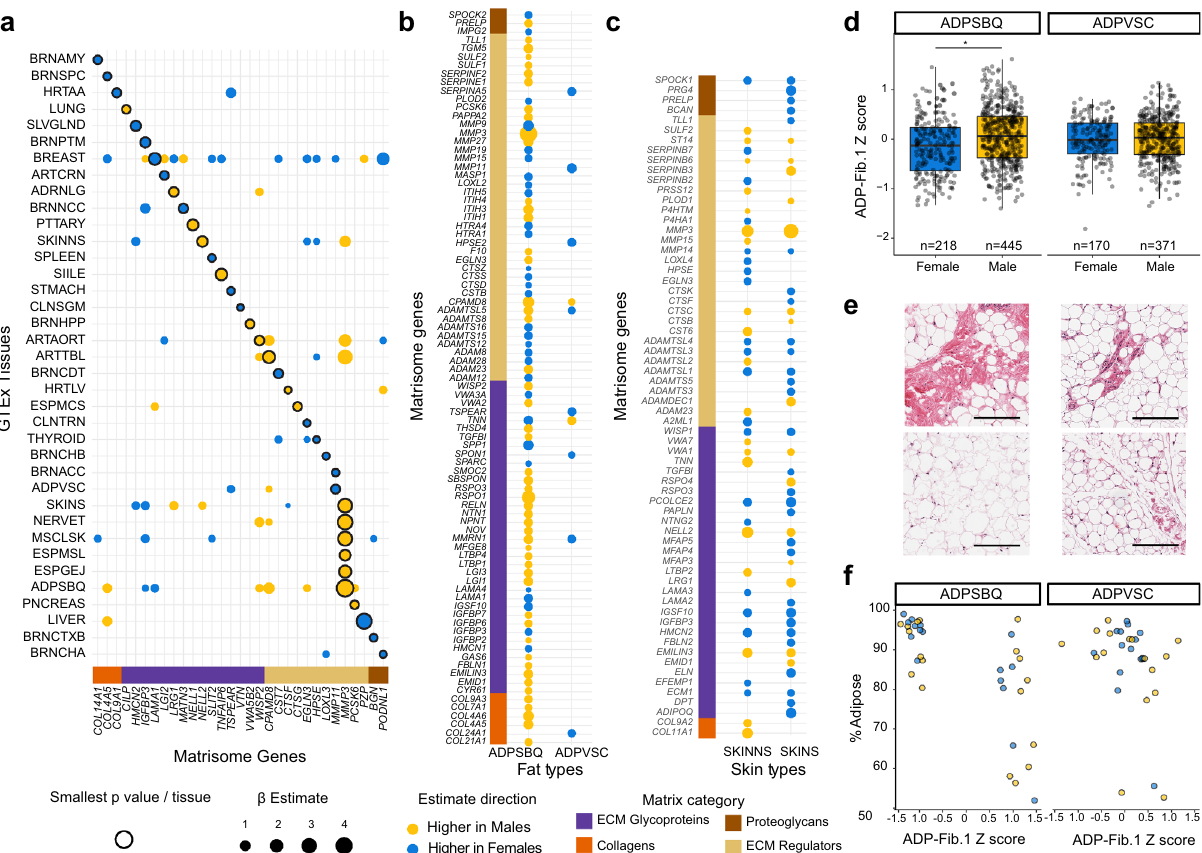
Figure 3. Sex based differences in the matrisome transcriptome. ( a ) A plot of sex DE genes. The transcript with the smallest p-value per tissue is noted along with all instances of that transcript having a significant β estimate in other tissues. Tissues with no significant findings were not included. ( b ) The sex-related genes that are DE in ADPSBQ and ADPVSC. Notably, ADPSBQ has 81 DE genes while ADPVSC has only 10. ( c ) The sex-related genes that are DE in skin not sun exposed (SKINNS) and skin sun exposed (SKINS). The size of the dot indicates the β estimate. The tissues are mostly congruent, having 17 shared genes with the same expression directionality. ( d ) A barplot comparing the Z score for the ADPSBQ ADP-Fib.1 gene cluster between males and females for both ADPSBQ and ADPVSC tissues. In ADPSBQ, which has more DE sex genes, cluster ADP-Fib.1 associates with the male sex. This cluster shares 11 genes with the DE gene list in ( b ). In ADPVSC, there is no sex difference. *=1.96e−05 ( e ) Adipose samples from two individuals showing differing levels of fibrosis. The top samples are from GTEX-IGN73 and the bottom samples are from GTEX-1K2DA. The left samples are ADPSBQ and the right samples are ADPVSC. The bar is 200 um. ( f ) The median percent adipose tissue from ADPSBQ (n = 34; 16F/18M) and ADPVSC n = 34; 16F/18M) samples, with the ADP-Fib.1 Z-score on the X axis. This data shows that the gene transcripts in the ADP-Fib.1 cluster positively correlate with adiposity and negatively correlate with fibrosis in ADPSBQ